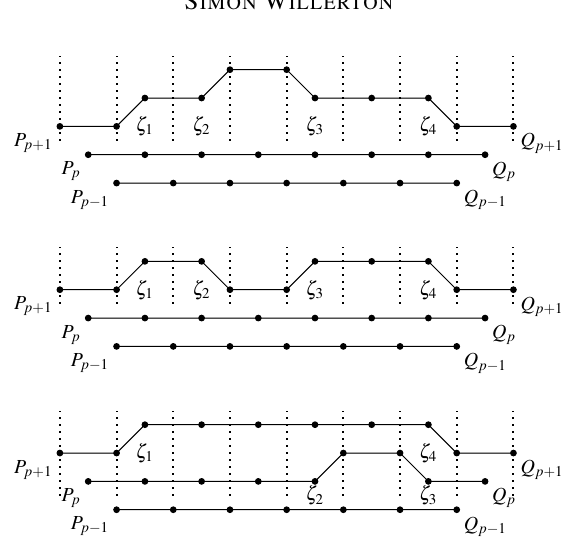
Figure 6: The three types of ( p + 1 ) -collection with two ascents and two descents, with the zones of the ascents and descents marked